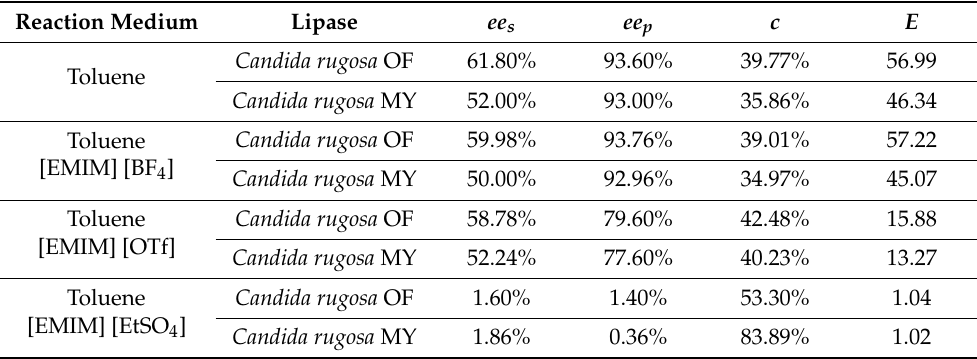
Table 1. List of obtained results of performed enantioselective biotransformation of (R,S)-atenolol after 120 h of incubation: enantiomeric excesses of substrates ( ee s ), products ( ee p ), conversion ( c ), and enantioselectivity ( E